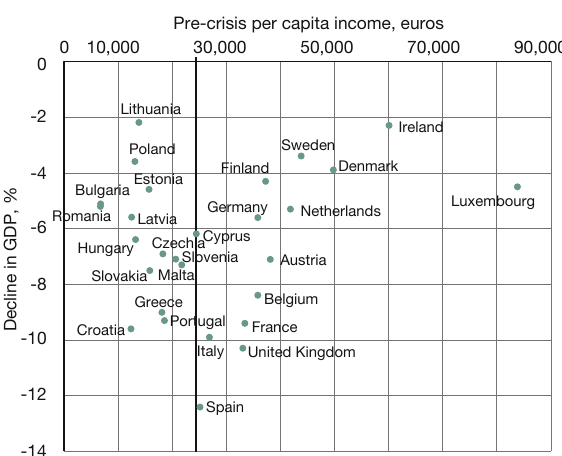
decreased only slightly and at PPS signifi cantly. Southern European countries, on the other hand, lagged behind the richer north-west. Greece, Portugal and Spain experienced higher growth than the EU core only until 2008 with 14.9% (at PPS even 38.2%), while the core grew by 10.7% (respectively 24.1% at PPS). Ireland started its dramatic catching-up pro- cess around 1990. Its per capita income grew from 70%